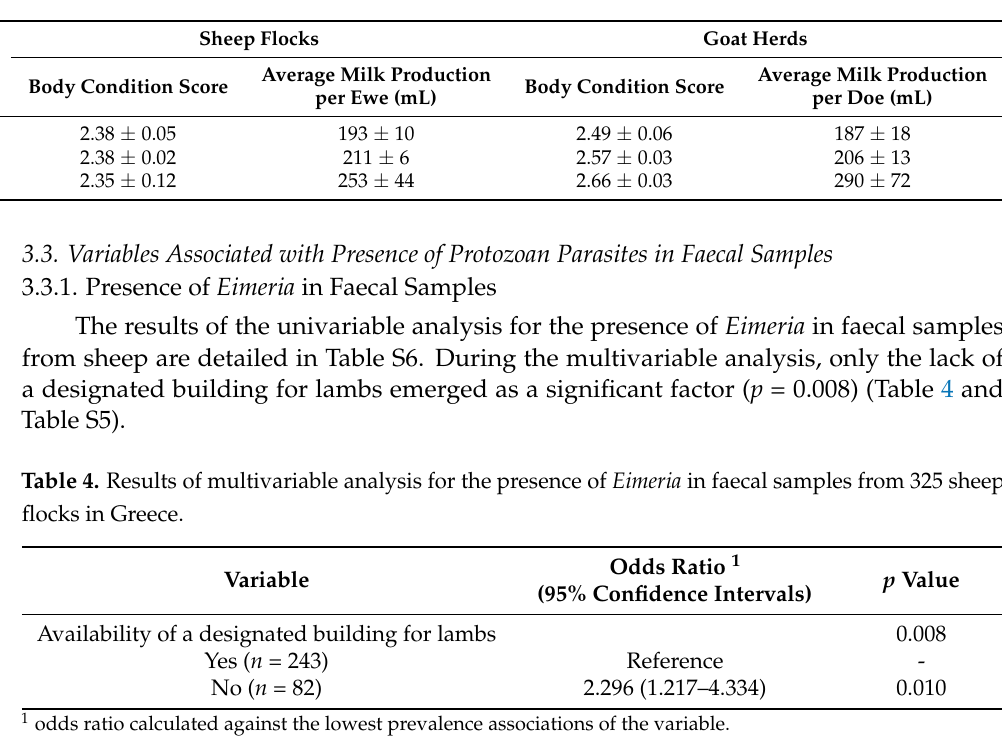
Table 3. Association of presence of protozoan parasites in pooled faecal samples with body condition score and milk production (mean ± standard error of the mean) on 444 small ruminant farms in a